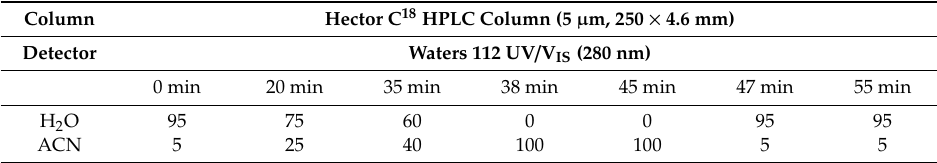
Table 2. Analysis condition of